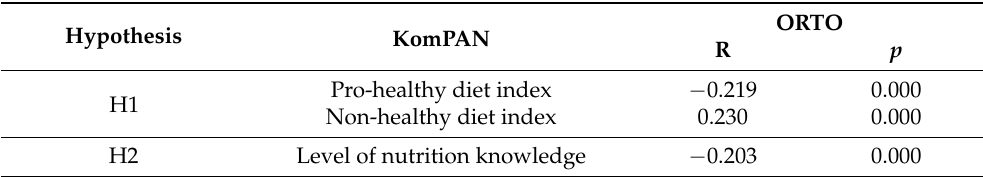
Table 4. Correlations between the intensity of orthorexia as measured by ORTO-6 questionnaire and the level of nutrition knowledge as measured by KomPAN questionnaire. ORTO Hypothesis KomPAN R p Pro-healthy diet index − 0.219 0.000 H1 Non-healthy diet index 0.230 0.000 H2 Level of nutrition knowledge − 0.203